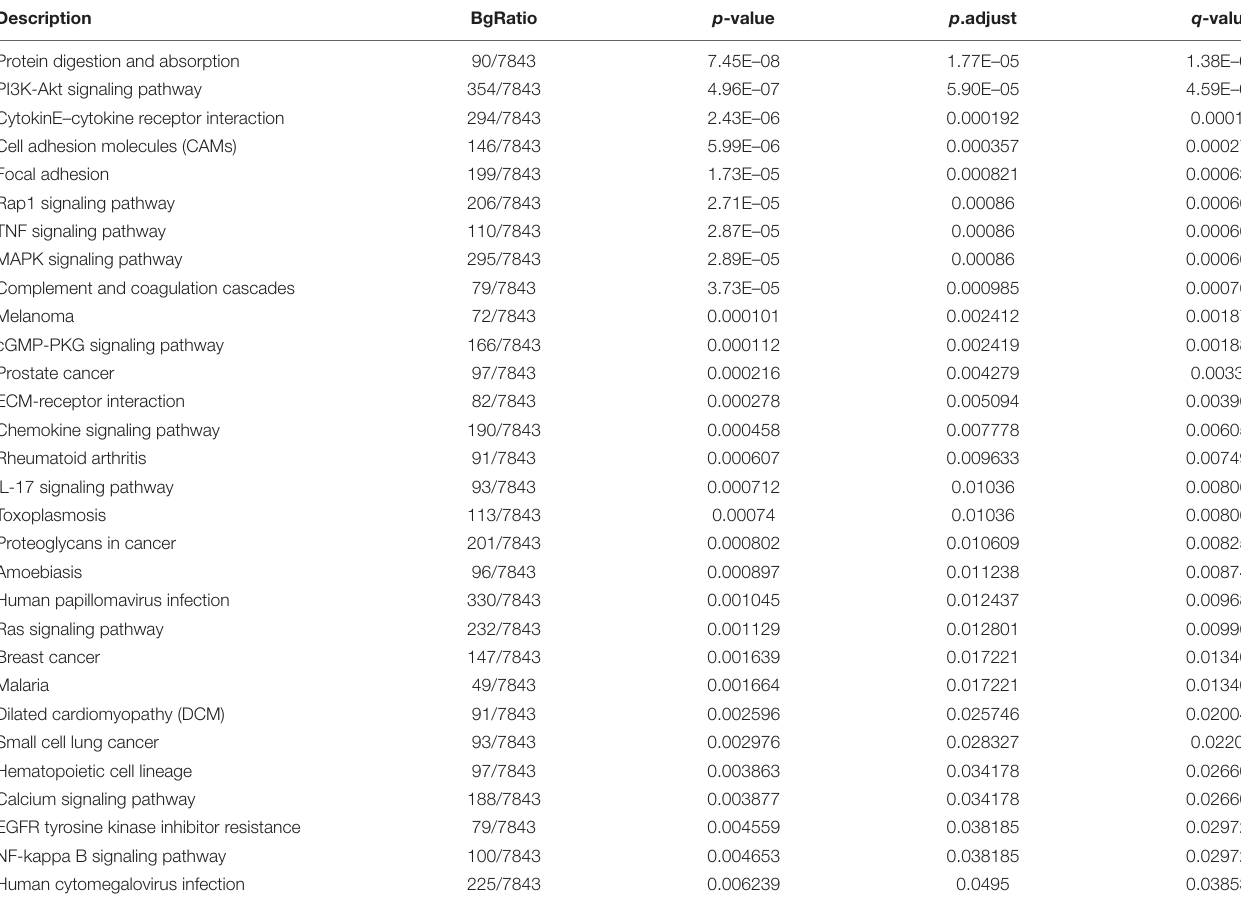
TABLE 2 | KEGG pathway analysis for